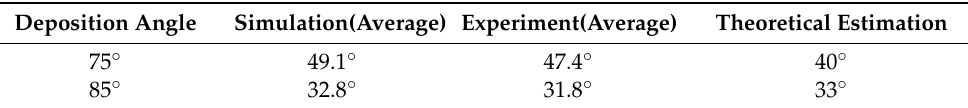
Figure 13. Ag thin film obtained from experiment under various deposition angles. Table 3. Comparison of nanocolumns’ average tilt angle between simulation, experiment, and theoretical